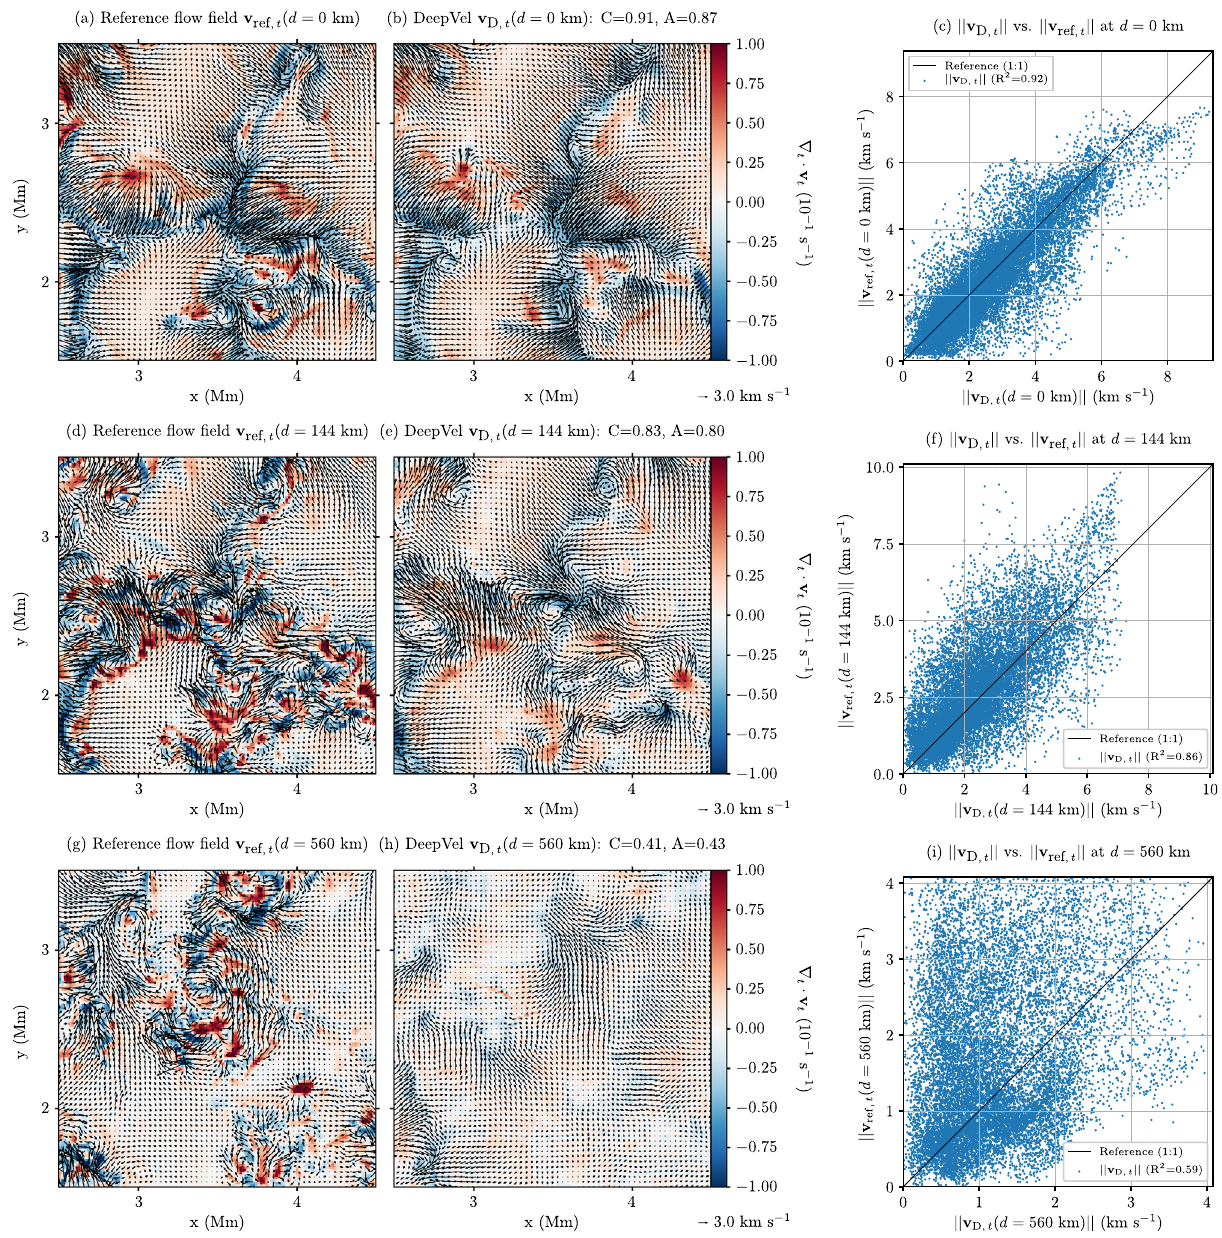
Fig. 3. Below the surface velocity inversions, MURaM-QS dataset. Patches of 125 by 125 pixels 2 extracted from instantaneous transverse velocity fi eld maps which were computed at geometrical depths (top) d = 0 km, (middle) d = 144 km, (bottom) d = 560 km by (left column) the MURaM-QS simulation (Vögler et al., 2005) and (middle column) single-layer output versions of DeepVel. The divergence of the transverse plasma motions (i.e., r t (cid:6) v t ) is displayed as colored background to emphasize the complexity of the structures that arise at increasing depths. (Right column) Scatterplots comparing amplitudes || v D , t || to || v ref, t || at each geometrical depth. The black line represents the expected solution (i.e., a coef fi cient of determination R 2 =